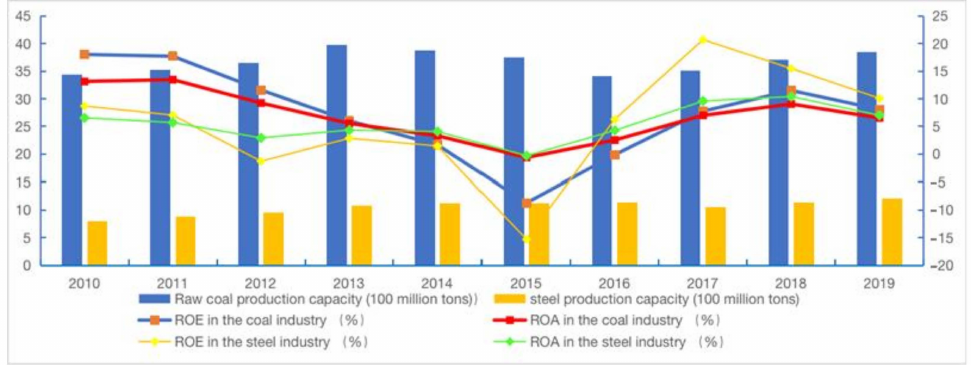
Figure 1. Changes in production capacity, ROE and ROA in the steel and coal